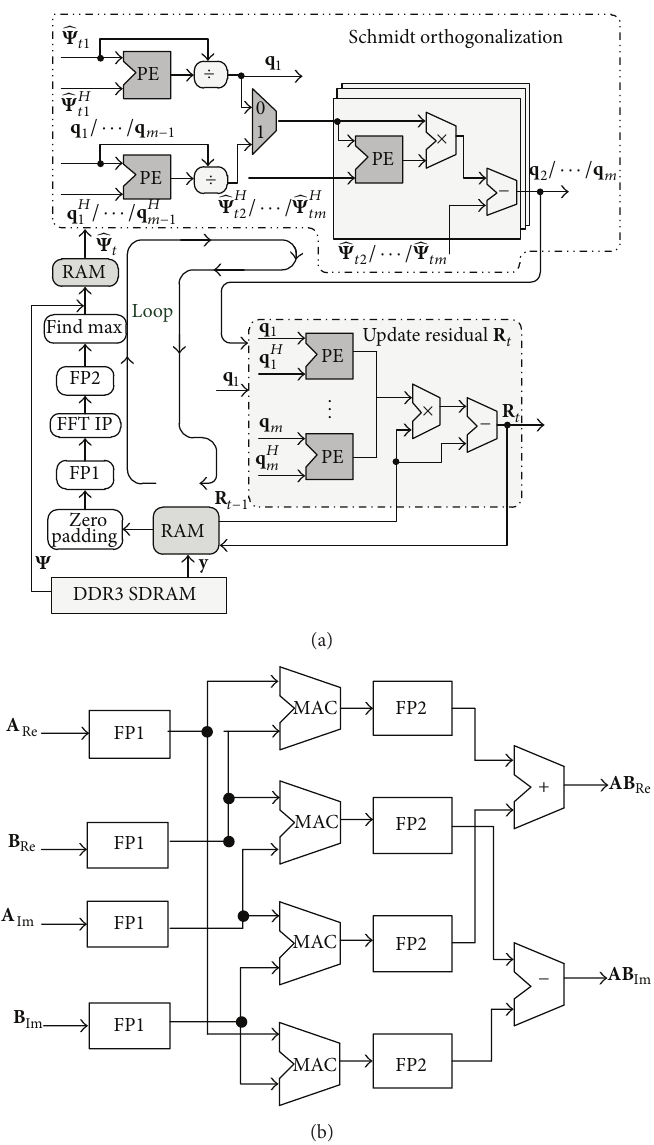
Figure 3: (a) Hardware structure of AS. (b) Inner structure of